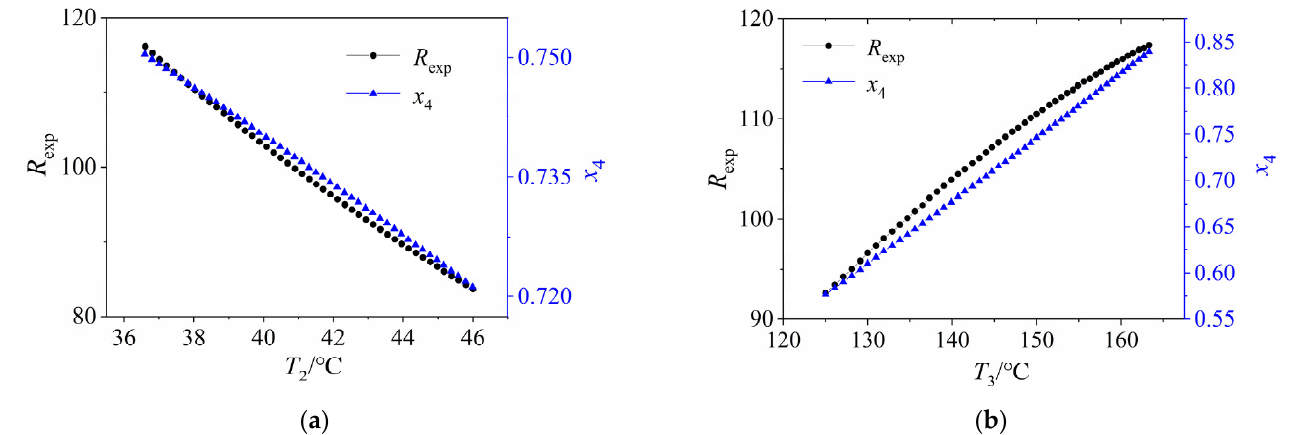
Figure 4. The variation of expansion ratio and dryness at the outlet of the expander with ( a ) T 2 ; ( b ) T 3.